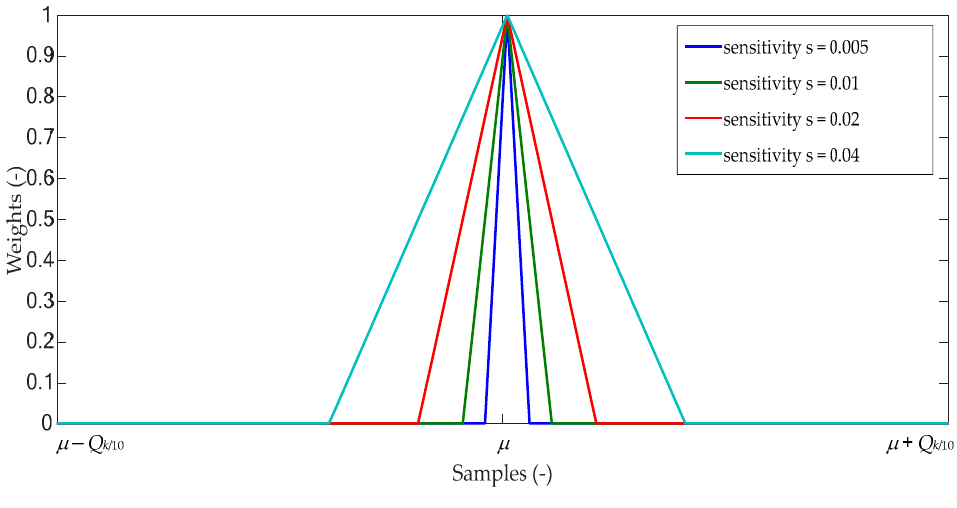
Figure 4. The assignment of weights by using the Triangle function in Equation (5) as the membership function.